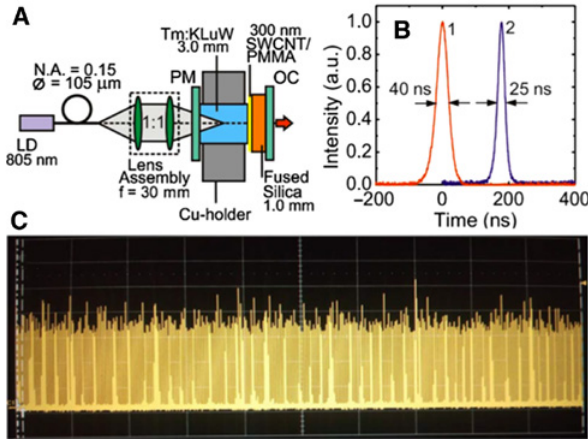
Figure 9: The schematic setup and the shortest pulse duration and the pulse train. (A) Schematic setup of the CNT SA Q-switched Tm:KLW microchip laser, LD, laser diode; PM, pump mirror; OC, output coupler. (B) The shortest pulses with T = 10% OC at 1.92 μ m (curve 1, pulse duration of 40 ns) and T = 1.6% OC at 2.13 μ m (curve 2, pulse duration of 25 ns), and (C) the stable pulse train with a repetition rate of 620 kHz at 2.13 μ m under an absorbed pump power of 3.8 W(time span 0.5 ms). Loiko et al. [137] © The Optical Society of America